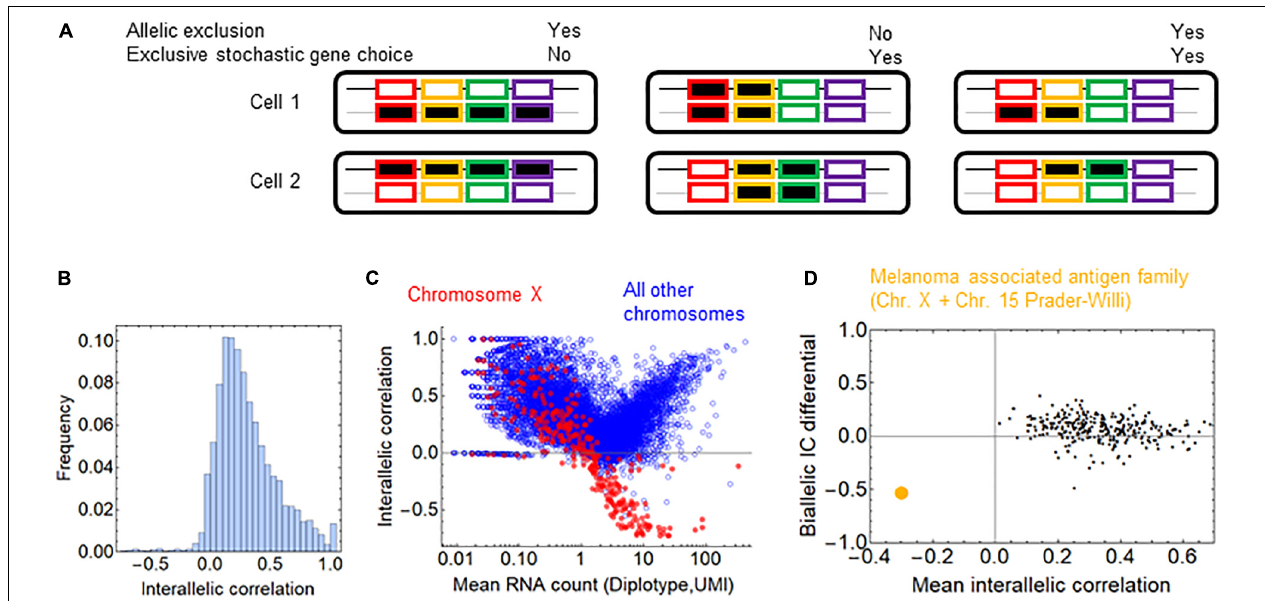
FIGURE 5 | Allelic exclusion and exclusivity in stochastic gene choice. (A) Schematic representation of different combinations of exclusivity in allelic and gene choice in an array of four genes. The black and gray lines represent the maternal and paternal chromosomes. The rectangles with no or black filling represent the OFF and ON expression states, respectively (B) The interallelic correlation in fibroblasts (Larsson et al., 2019). Negative correlations indicate the allelic exclusion. (C) The relation between RNA count and interallelic correlation. The genes on the chromosome X are shown in red. (D) The melanoma-associated antigen gene family is highlighted in orange among the gene families. It is the only family with negative mean interallelic correlation.